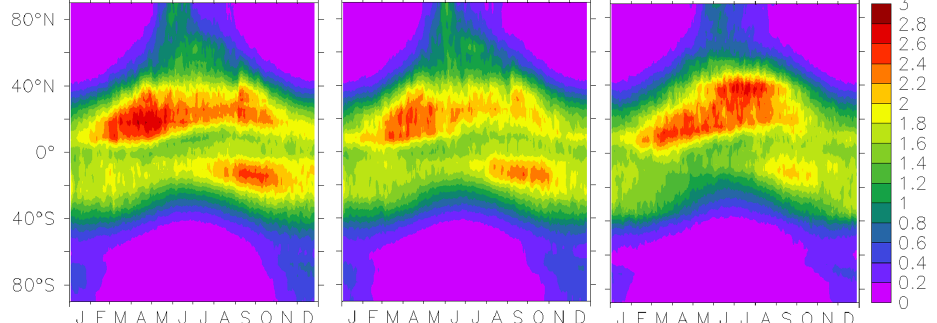
Figure 4. Zonal mean OH number concentration (10 6 moleculescm − 3 ) at the surface for the year 2000 from the CMAC-FV (left), CMAC-SE (middle) and maEMAC (right)